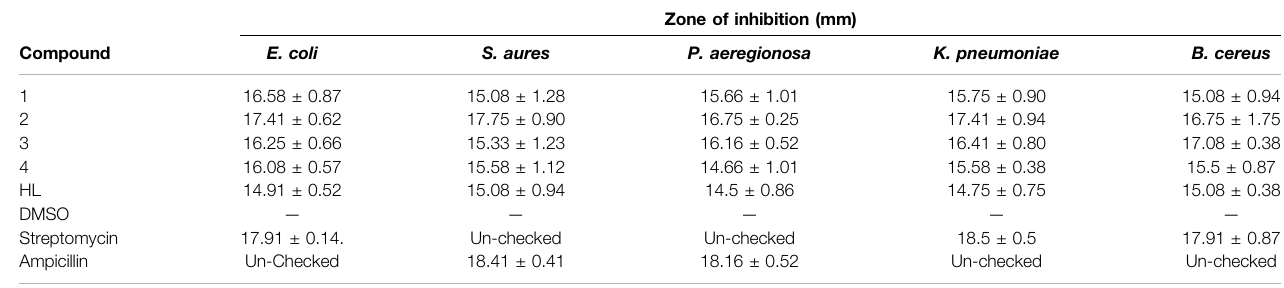
TABLE 4 | In vitro antibacterial activity of the screened compounds.